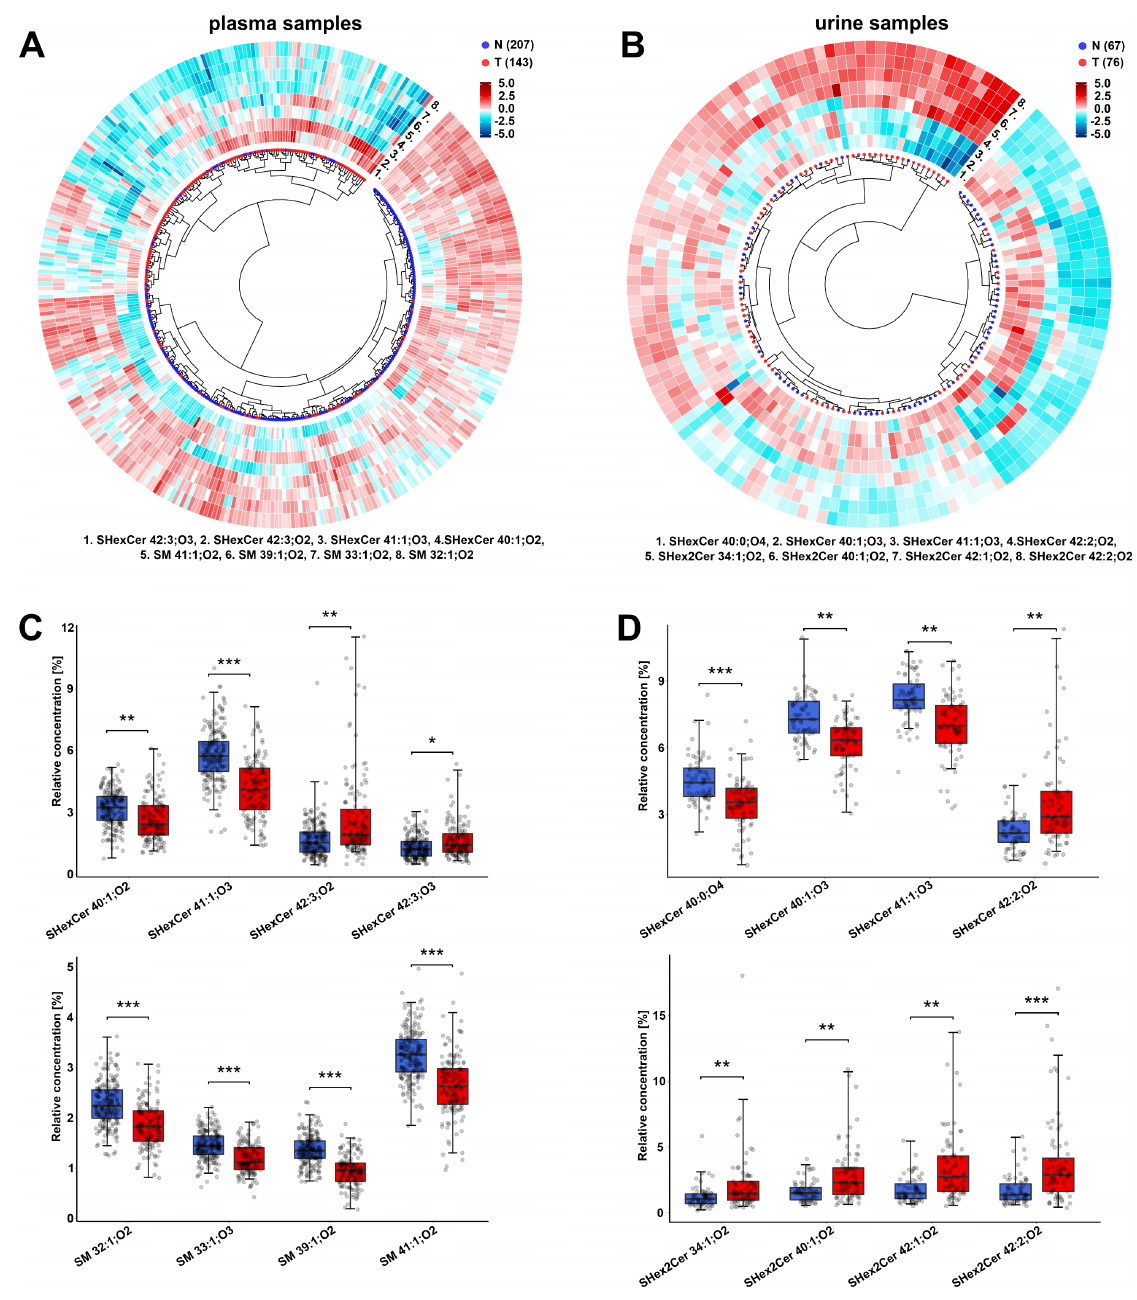
Figure 2. Important dysregulations observed in studied plasma and urine samples. Circular dendrograms with heat map calculated based on the relative concentrations of ( A ) the four most significant SM species and four most significant SHexCer species in 350 plasma samples or ( B ) the four most significant SHex2Cer and four most significant SHexCer species in 143 urine samples, demonstrating the classification of controls (N) and RCC cancer cases (T). Data were log-transformed and Pareto scaled, then the Euclidean distances were calculated and Ward’s clustering method was selected. The heatmap was generated using z-score scaling. Box plots of the relative concentrations of these significant lipids for controls and patients with RCC in the case of ( C ) plasma samples and ( D ) urine samples. The importance marked above the box plots includes the fold change (robust Hodges–Lehmann type fold change estimator), effect size, and FDR from the Mann–Whitney U test: *** large, ** medium, * small significance (see detailed explanation in Supplementary Data S2A,D).